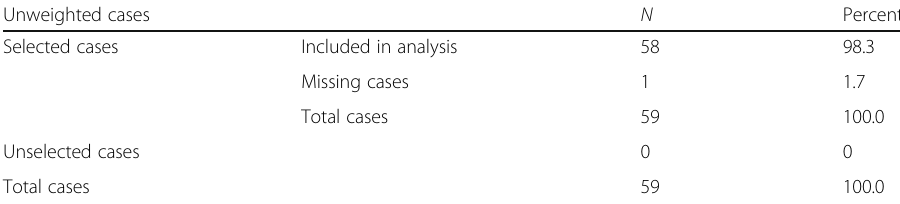
Table 3 Independent random variable X test cases Unweighted